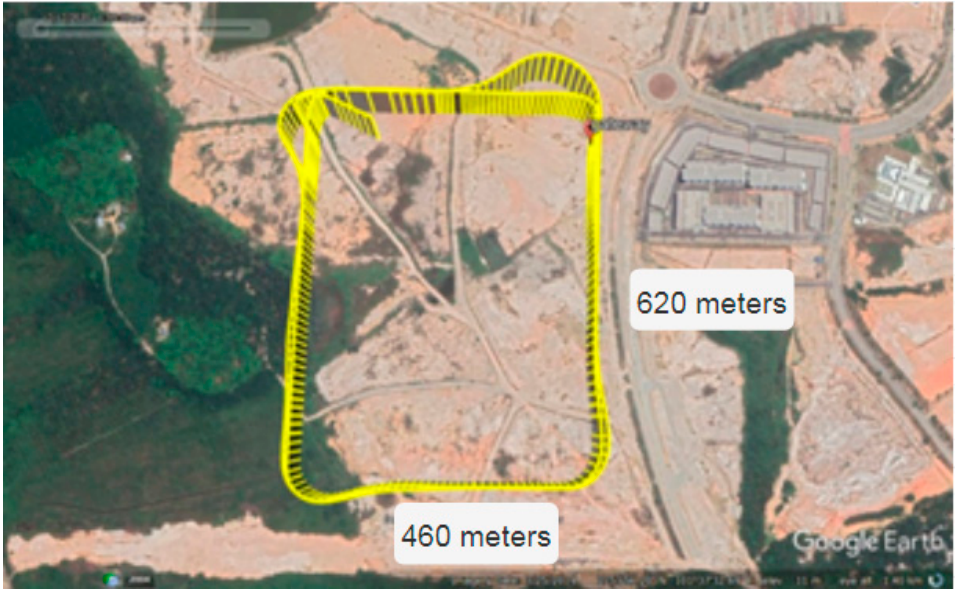
Figure 15. Aerial view of the location (Cyberjaya, Malaysia) for drone speed measurement.